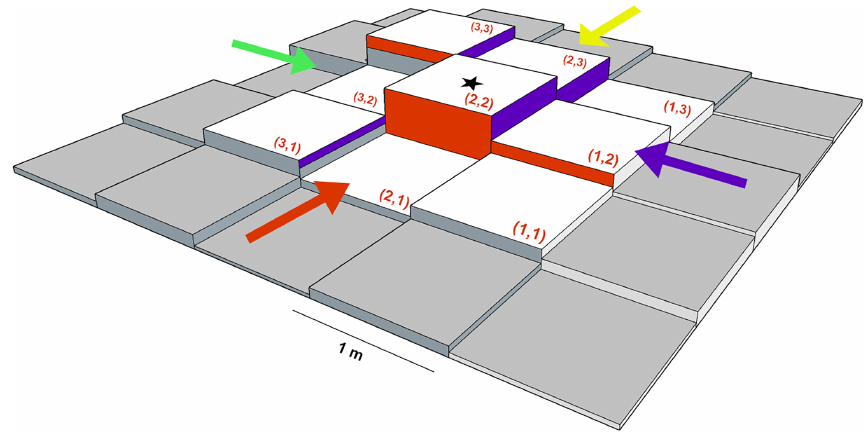
Figure 2. DEM-based block method for estimating the local drag generated by roughness elements on the surface. The total surface area that is perpendicular and “visible” to the direction of airflow (matching-coloured face area and arrows) is assigned to s b (Eq. 7). The displayed grid cell indices are for airflow in the direction of the red arrow. A F D_local value is estimated for the four cardinal wind directions, with the values assigned to the central grid cell of the block (starred). The block is then moved by one grid cell at a time and the process is repeated over the